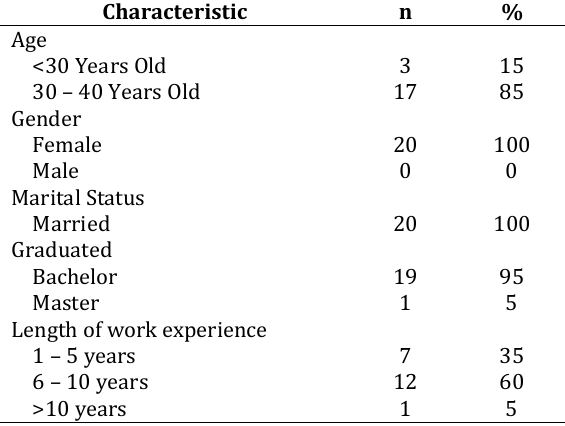
Table 1. Characteristics of Participants